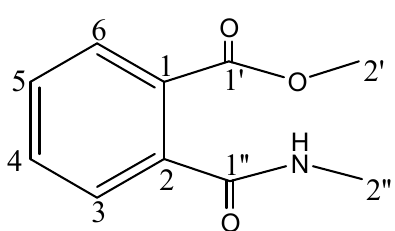
Figure 2. Structure of compound 2 .